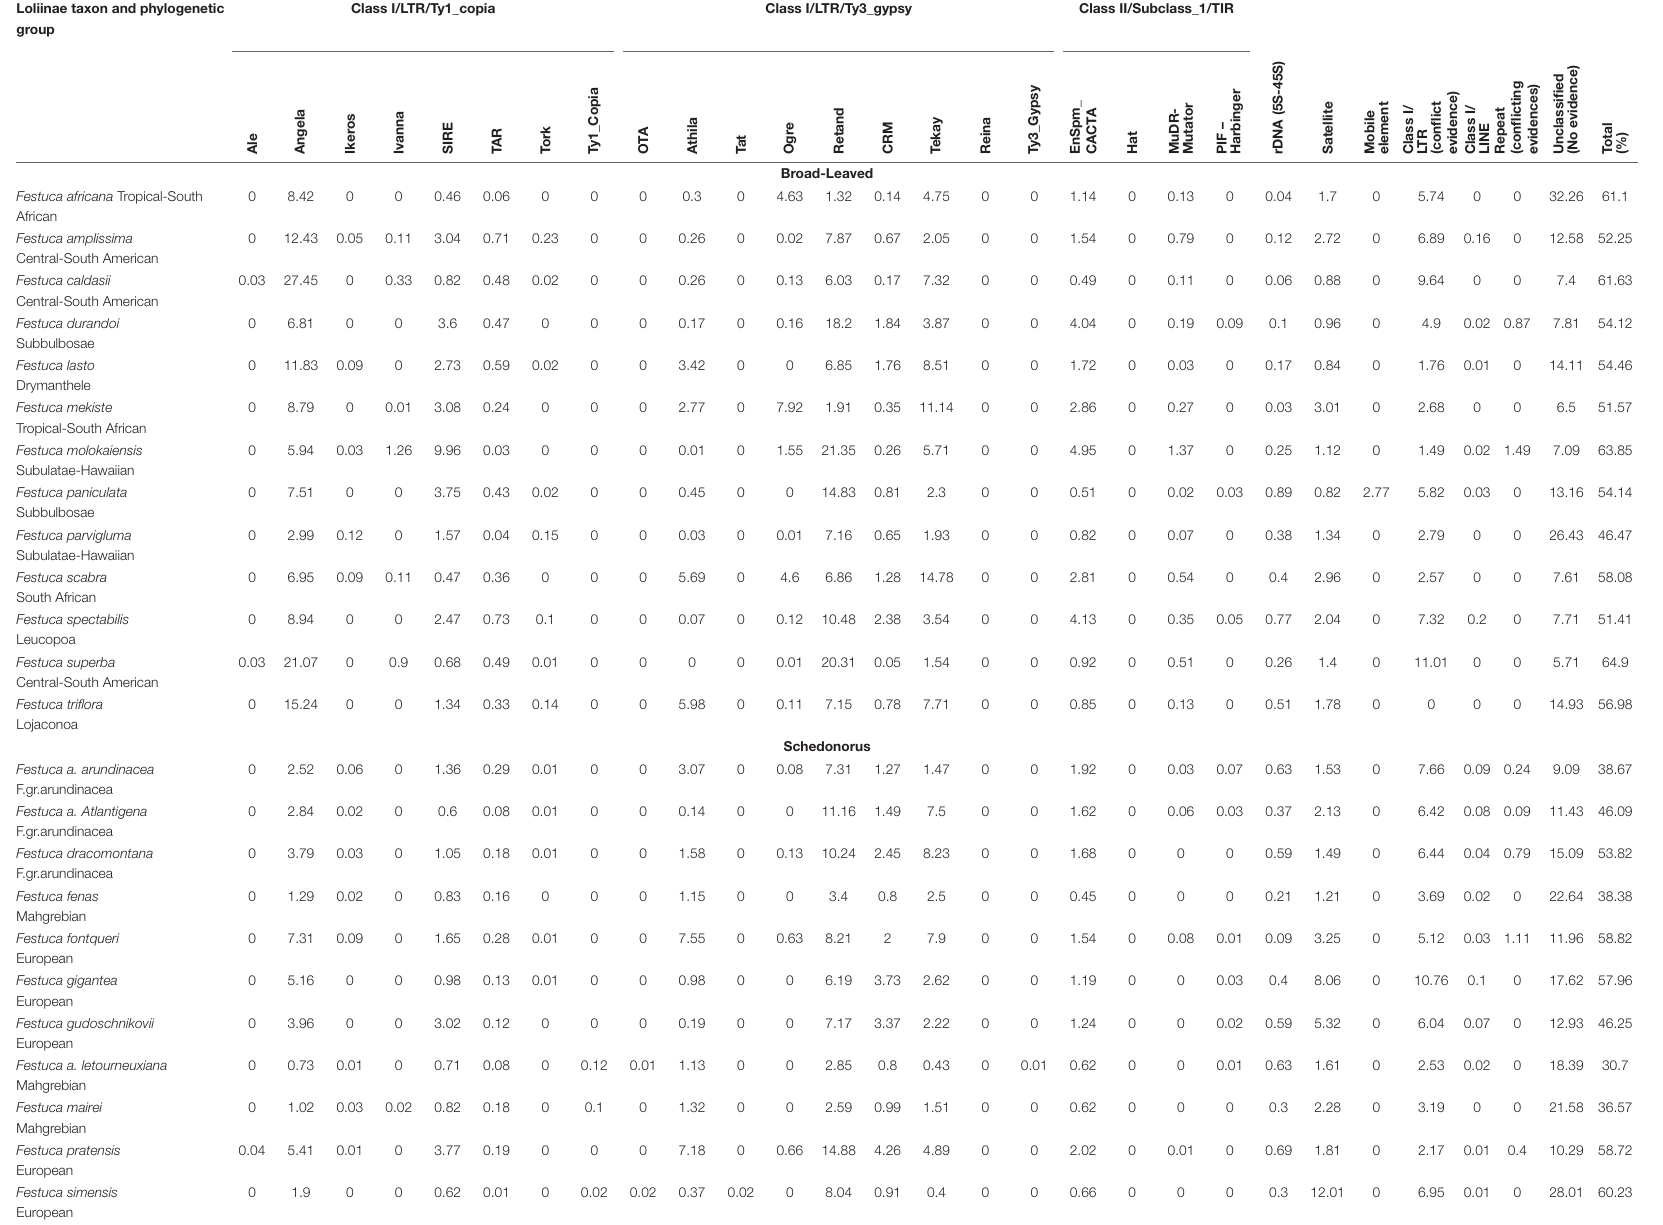
TABLE 2 | Genome proportion of repeats estimated by Repeat Explorer 2 for individual Loliinae samples (estimations per holoploid genome, 1C). Loliinae taxon and phylogenetic